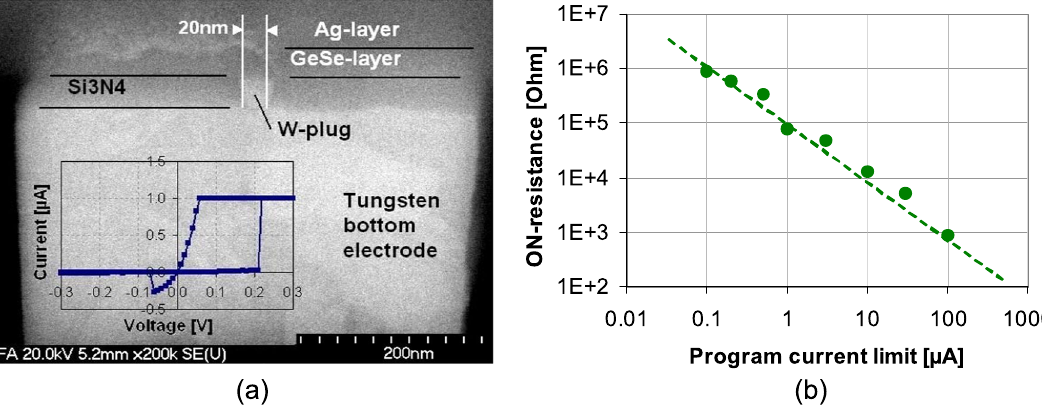
Fig. 8 a SEM and IV curve of CBRAM b dependence of the ON-state resistance on programming current for CBRAM devices at room tem- perature